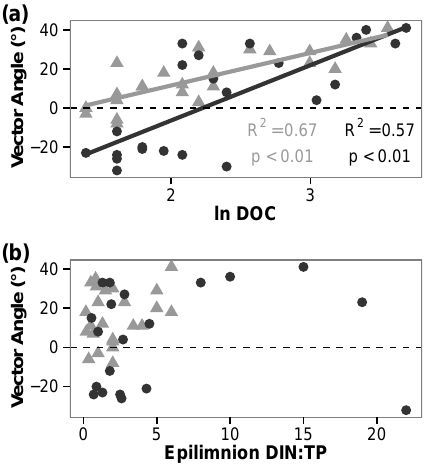
Figure 7. Vector angles in response to (a) DOC and (b) epilimnetic DIN : TP. Data from June are indicated by gray triangles; data from July are indicated by black circles. Dotted line indicates the bound- ary between P limitation (positive values) and N limitation (negative values). Only significant relationships are